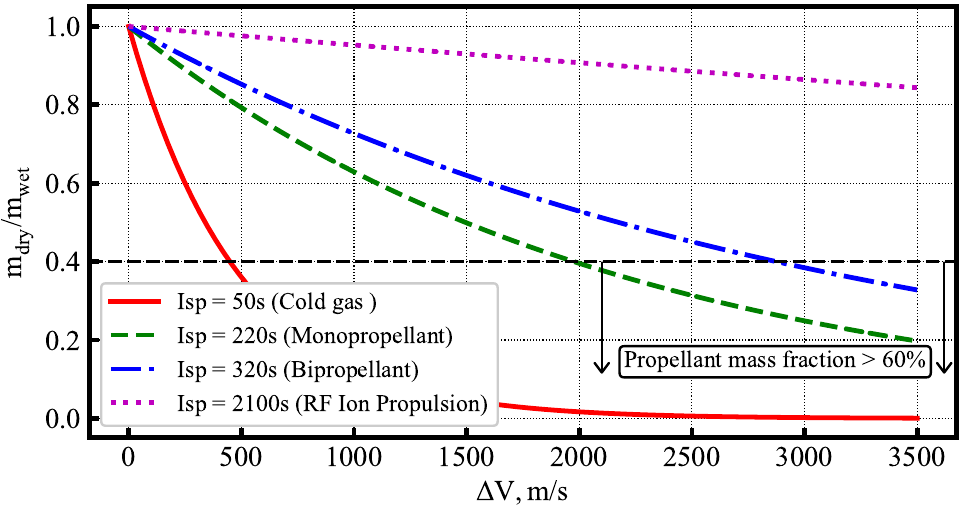
Figure 2. Dry-to-wet mass ratio as a function of ∆ V from the rocket equation. The dotted horizontal line demarcates the region below which the propellant mass fraction exceeds